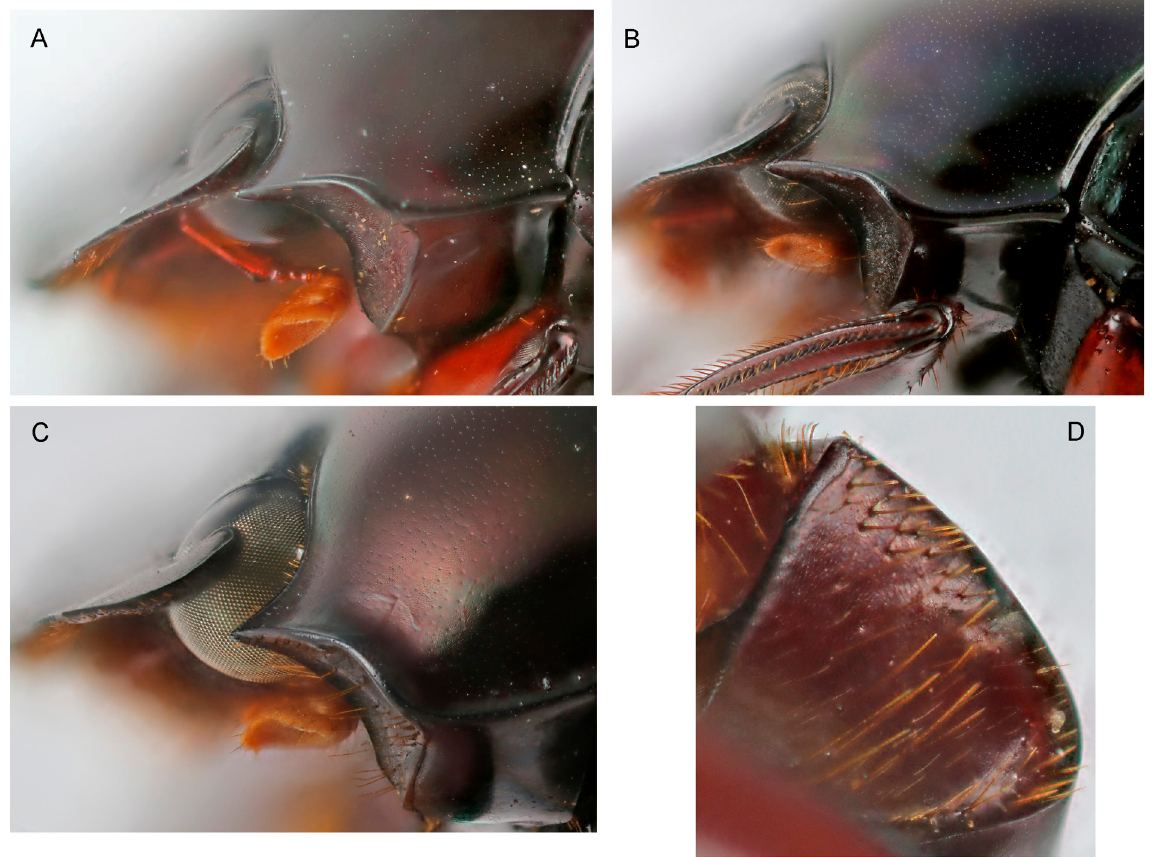
Fig. 35. Variation on the pilosity at the centre of the hypomeral cavity among members of the bridarollii subgroup. A . Sylvicanthon seag sp. nov. B . S. attenboroughi sp. nov. C–D . S. bridarollii (Martínez, 1949). Note the first two species have the hypomeral cavity entirely glabrous or with setae limited to